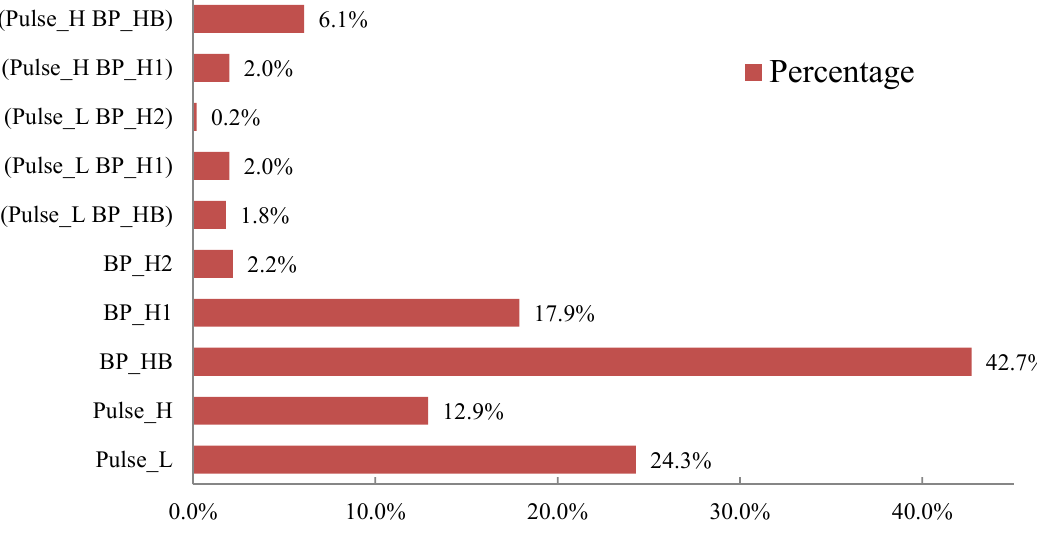
Figure 7. The distributions of vital signs states in the Queensland